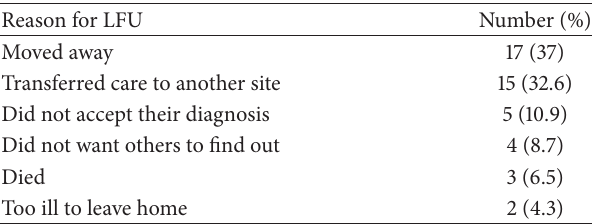
Table 4: Reasons for loss to follow-up documented by community health workers ( 𝑛 = 46